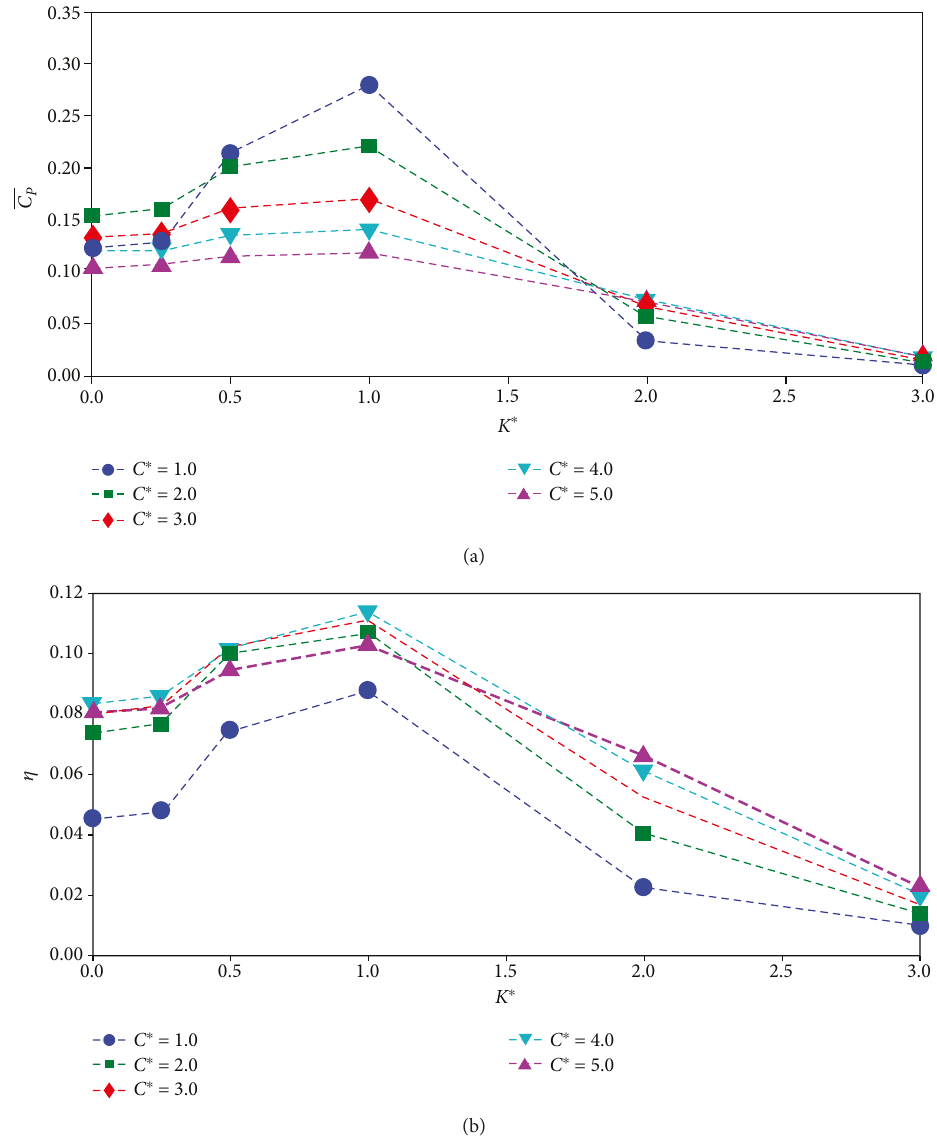
Figure 5: The mean power coe ffi cient and power e ffi ciency against spring coe ffi cient K ∗ with di ff erent damping coe ffi cient C ∗ ; (a) mean power coe ffi cient; (b) power e ffi